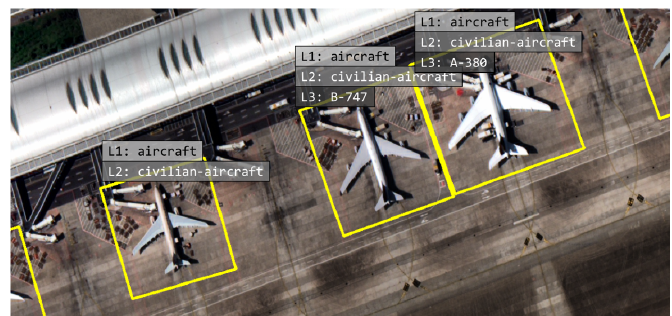
Figure 1. Demonstrative cases of annotated objects with the different labeling